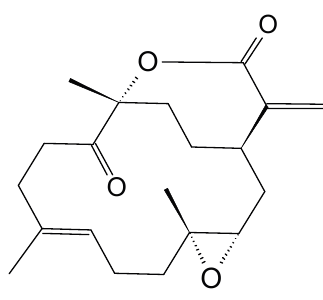
Figure 37. 11-Dehydrosinulariolide ( 110 ).